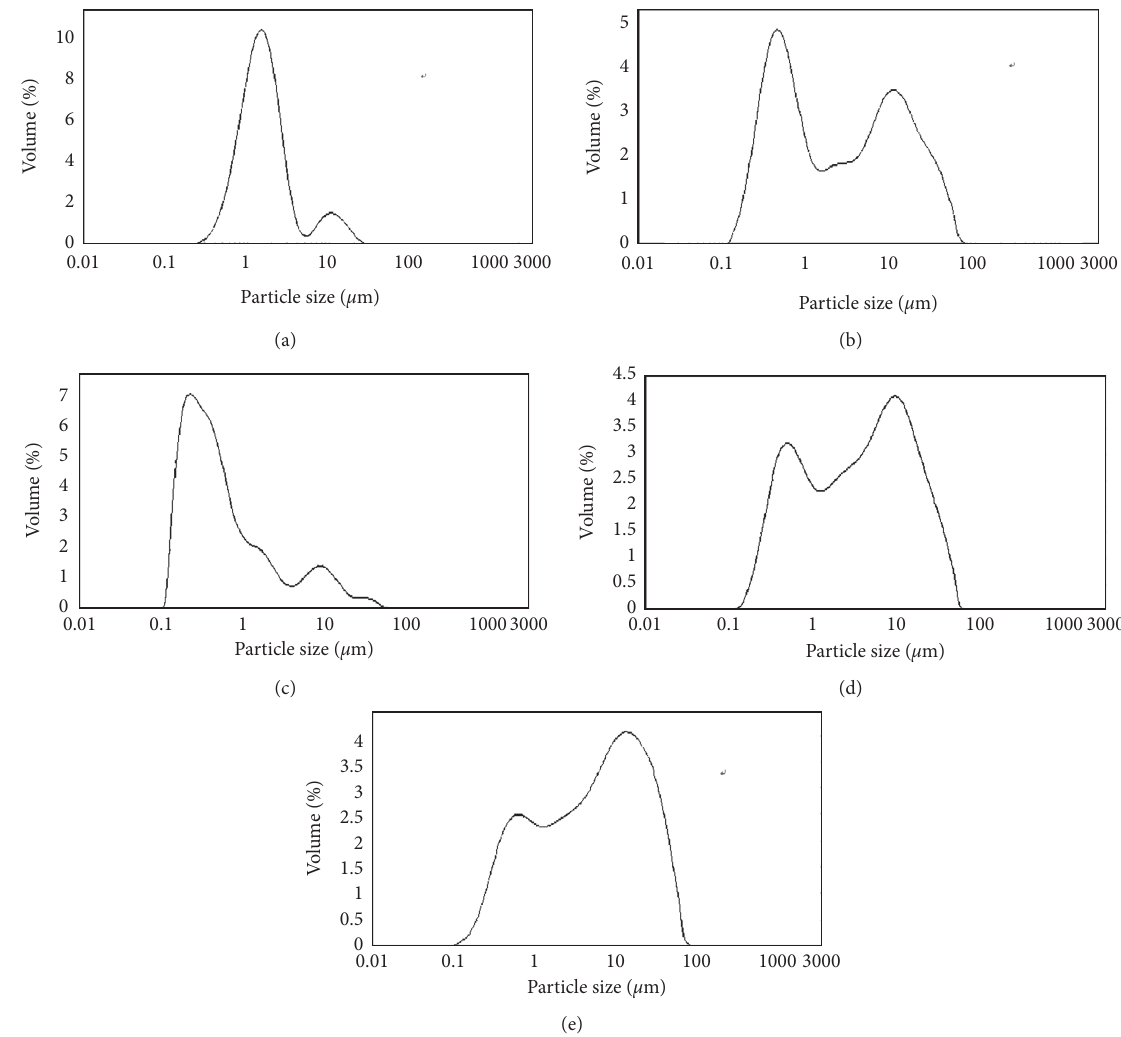
Figure 1: Size of the milled powder particles. (a) Milling 0 h. (b) Milling 0.5 h. (c) Milling 2h. (d) Milling 5h. (e) Milling